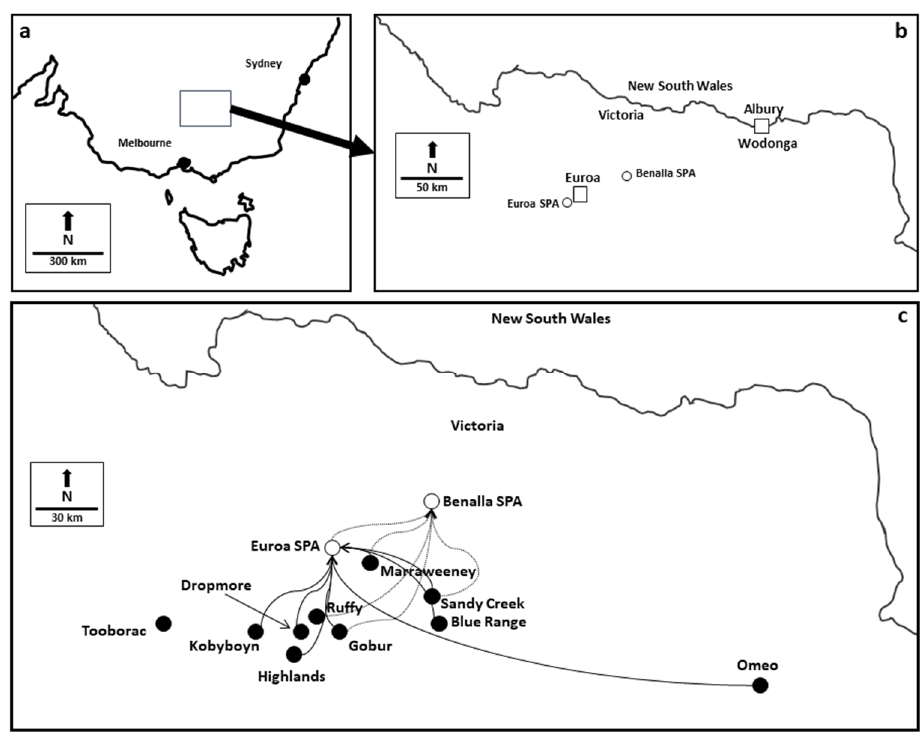
Figure 1. Location of ( a ) study sites in south-eastern Australia, ( b ) the two SPAs sampled and ( c ) source populations for each of the SPAs.